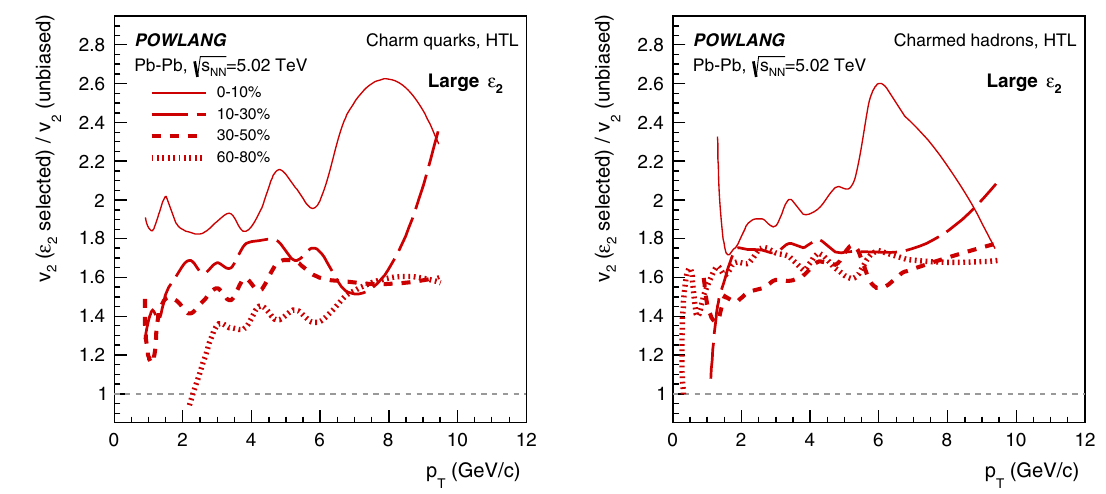
Fig. 12 The ratio of the v 2 coefficients for charm (quarks in the left panel, hadrons in the right panel) in high-eccentricity over unbiased events, for different centrality classes